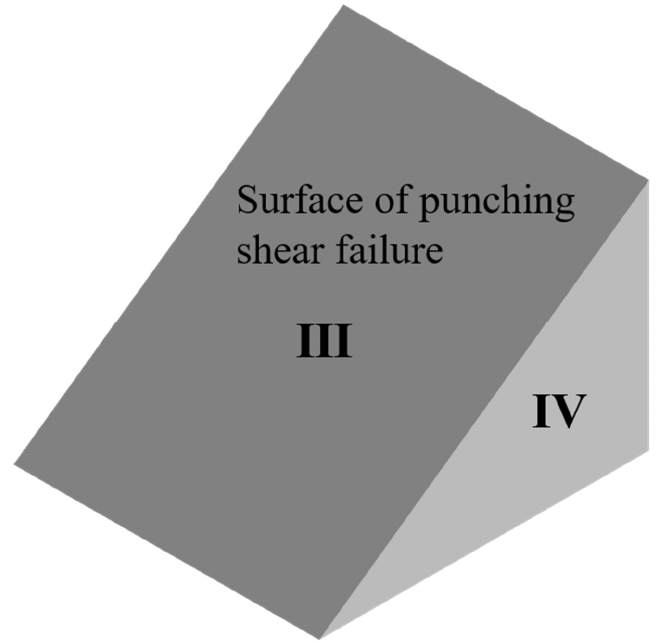
Figure 10. The prism free-body of punching shear failure.